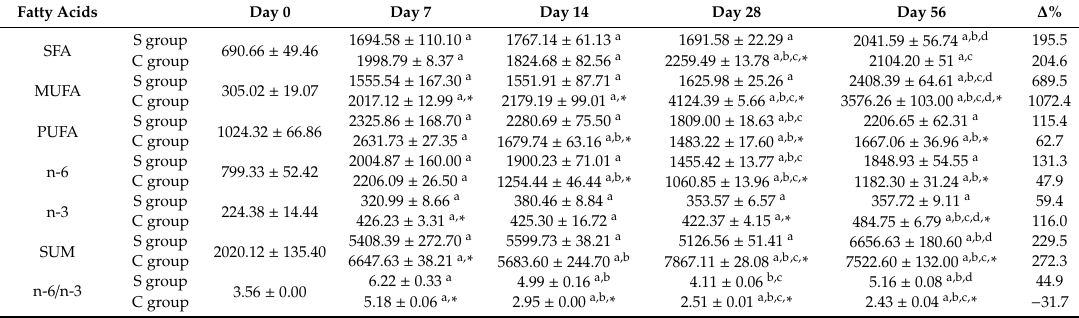
Results are expressed as mean ± standard error of three replicates for each group. Abbreviations: SFA, total saturated fatty acids; MUFA, total monounsaturated fatty acids; PUFA, total polyunsaturated fatty acids; SUM, the sum of all fatty acids evaluated. p < 0.05 as compared with 0 a , day 7 b , day 14 c , and day 28 d ; and S group *. ∆ %: percentage change from day 0.